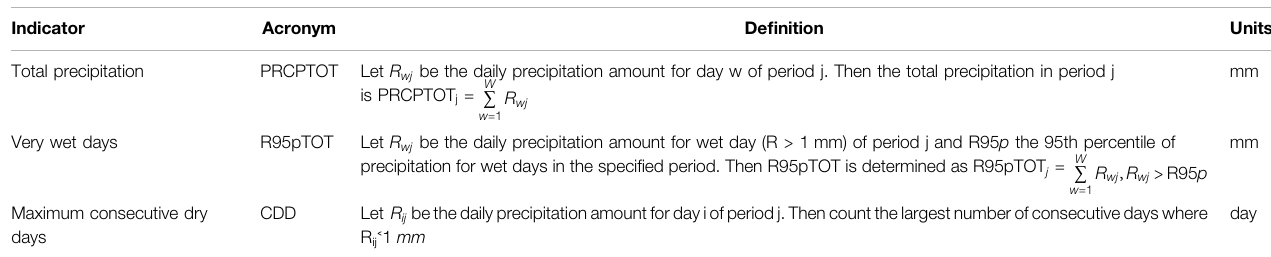
TABLE 2 | Indicators used in this